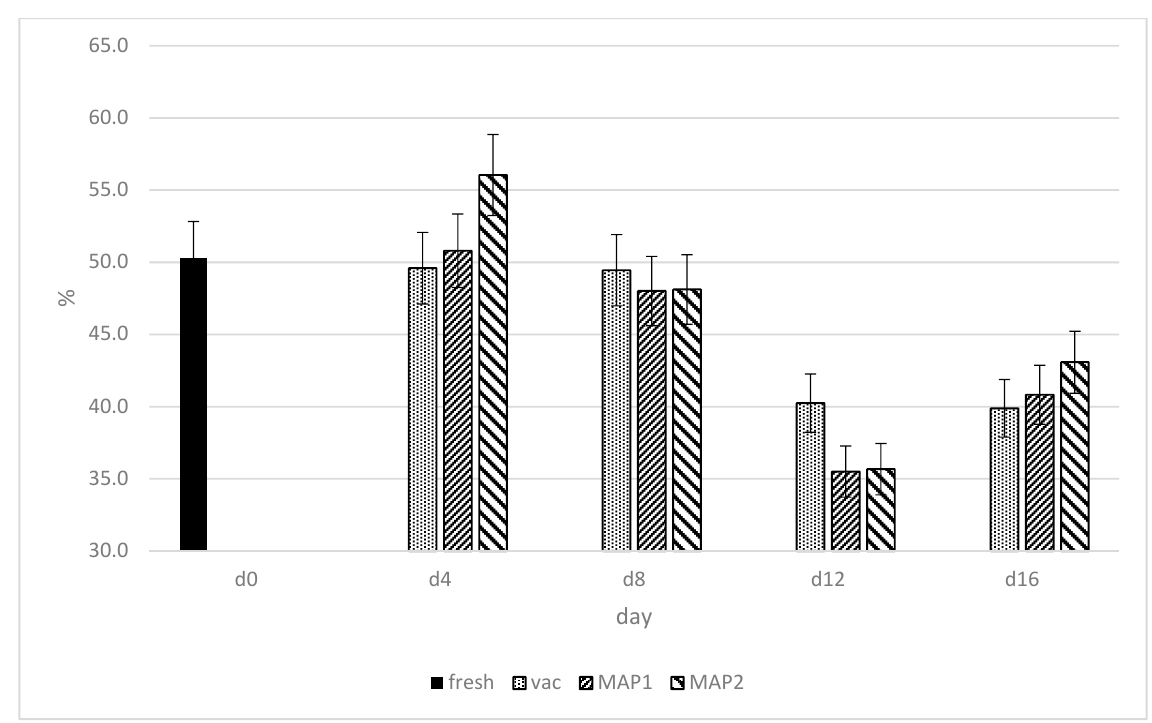
Figure 5. Changes (%) in the activity of DPPH free radical scavenging in ostrich muscles as influenced by the type of packaging and storage time in refrigeration.